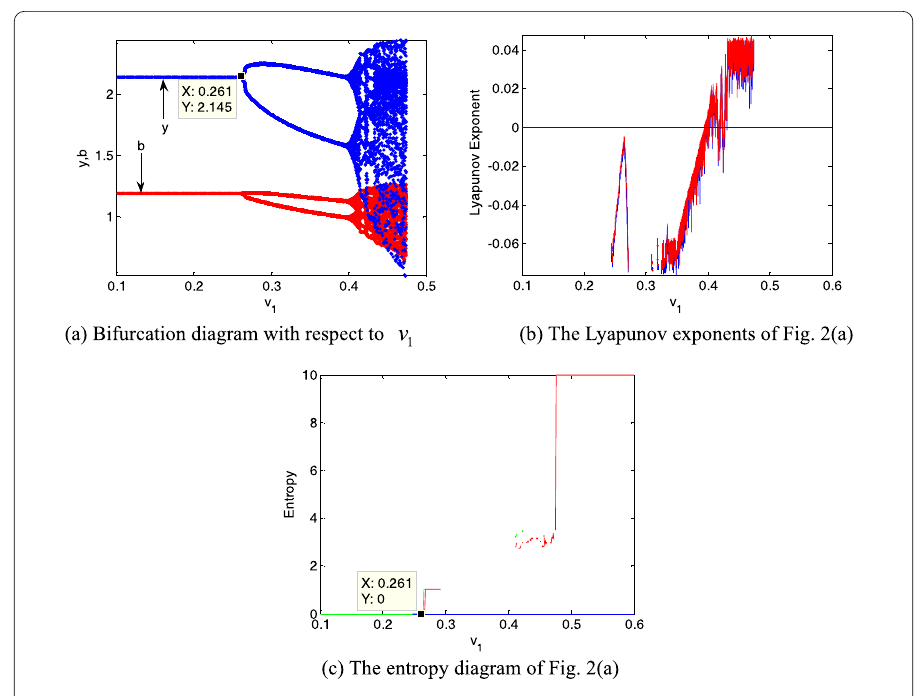
Figure 2 Dynamic evolution of decision variables with v